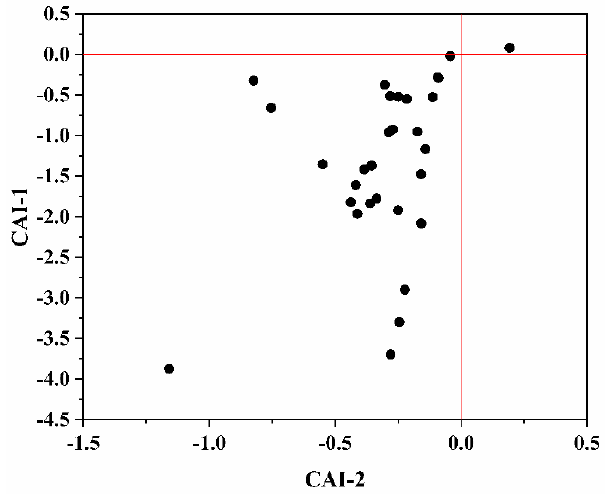
Figure 7. Chloro-alkaline indices of shallow groundwater.